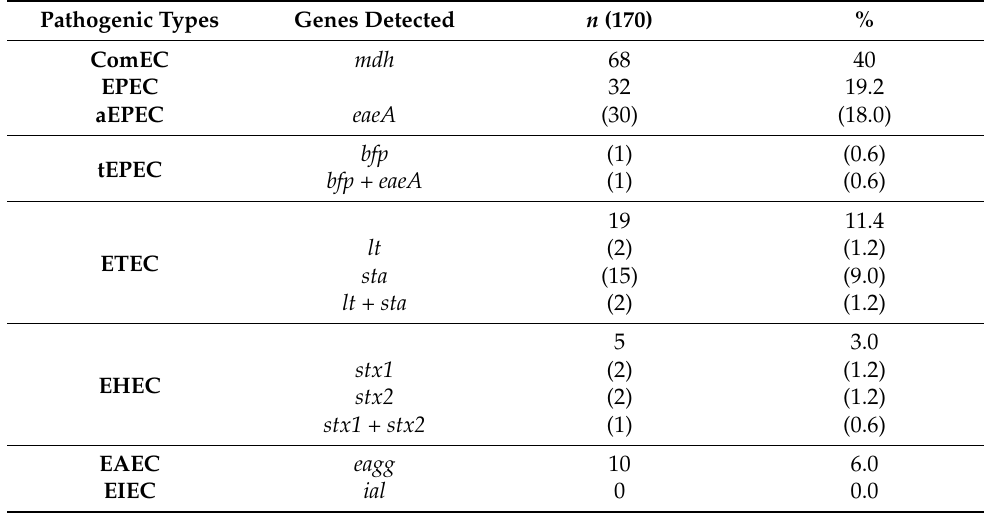
Table 2. Escherichia coli (single pathotype) and their virulence genes detected in this study.